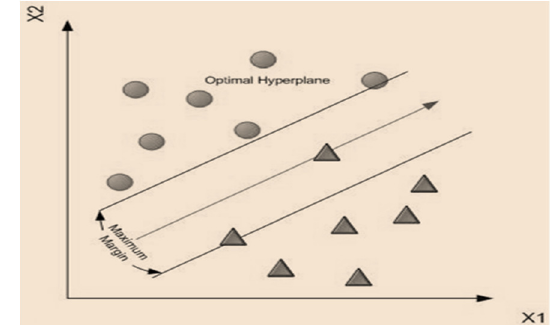
Fig. 3: SVM Hyperplane with Two Classes